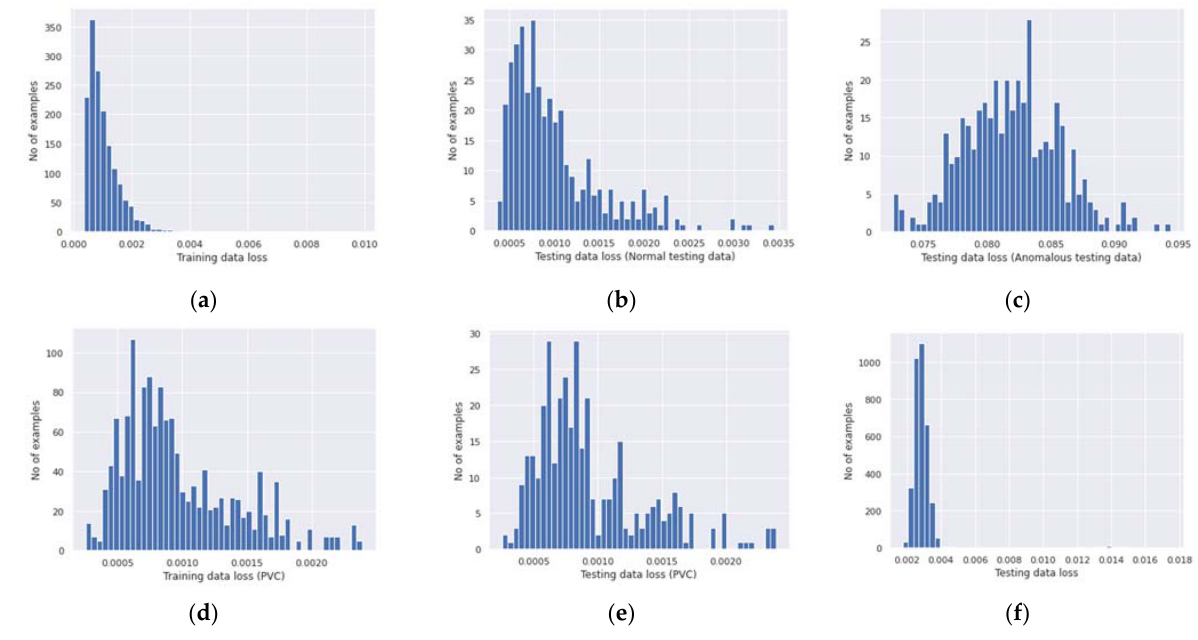
Figure 8. Training and testing loss distribution with number of samples: ( a ) MIT ‐ BIH training data; ( b ) MIT ‐ BIH normal testing data; ( c ) MIT ‐ BIH abnormal testing data; ( d ) INCART training data; ( e ) INCART testing data; ( f ) LTAFDB testing data.